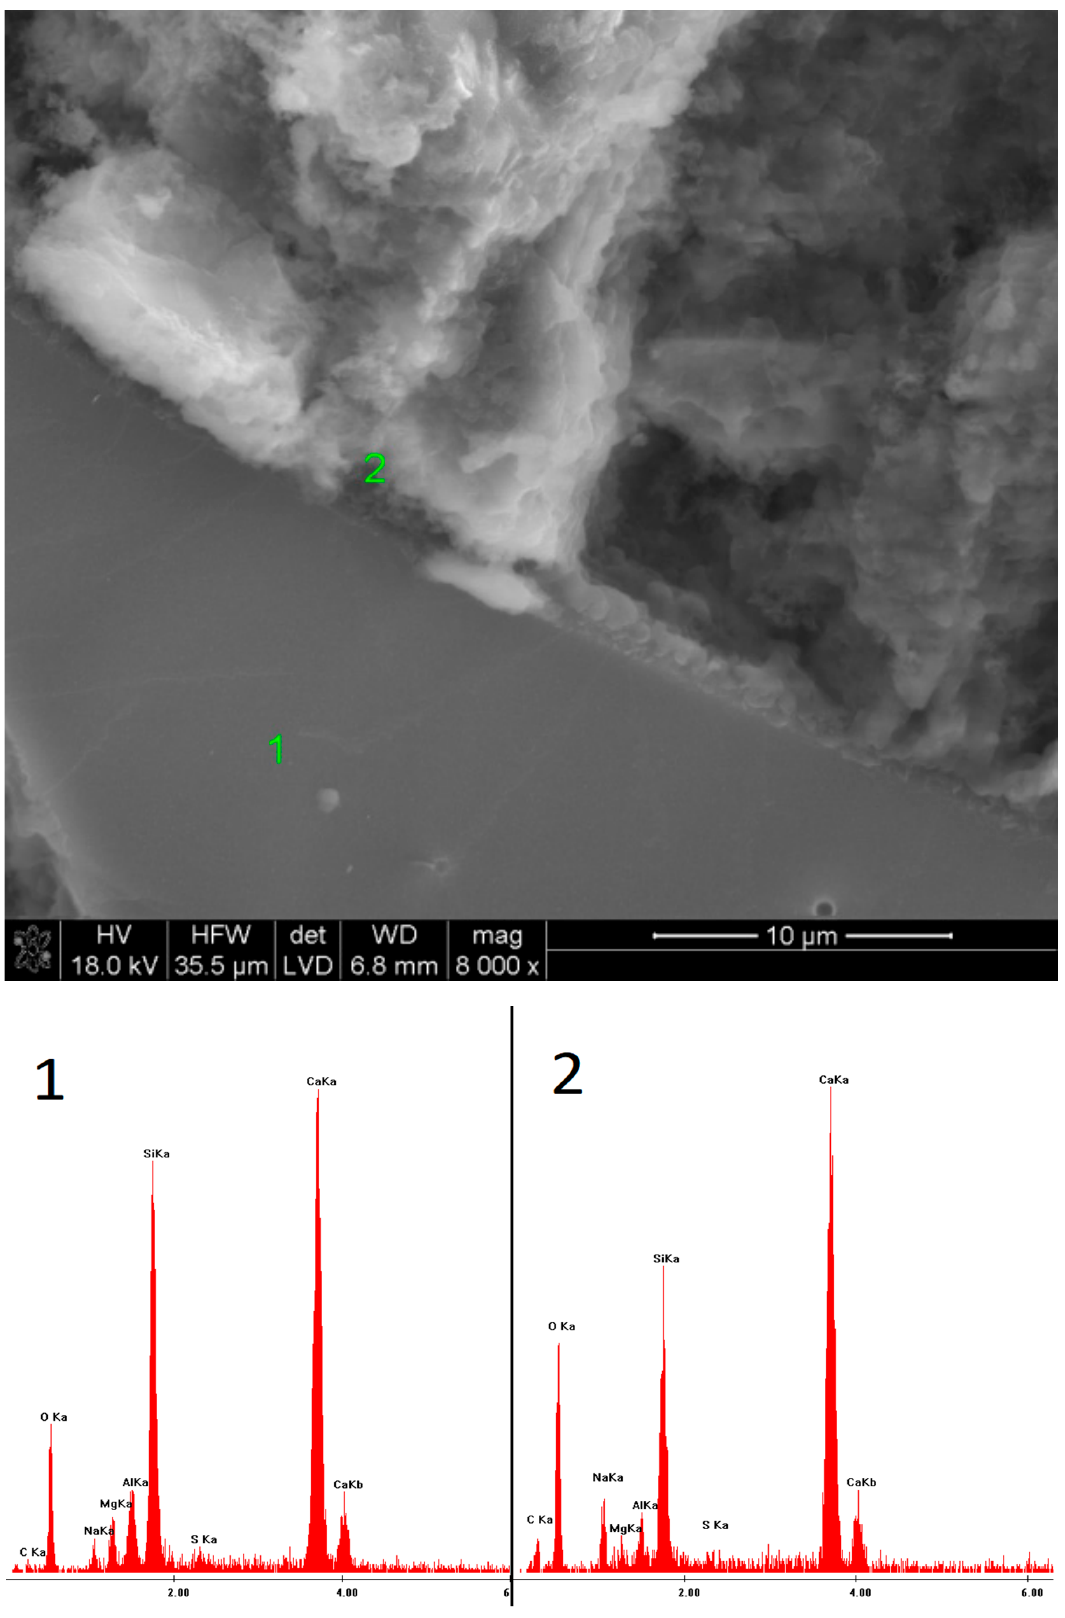
Figure 15. Microstructure of slag paste activated with sodium nitrate after 40 days of curing—SEM + EDS; 1 —unreacted slag grains; 2 —hydration products.